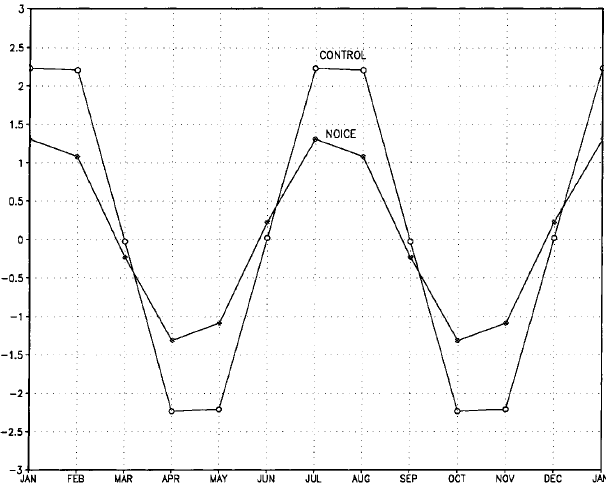
Fig. 7. Mean annual cycle of the second harmonic of the zonally averaged intensity of the subpolar trough for the control and the NOICE simulations (in